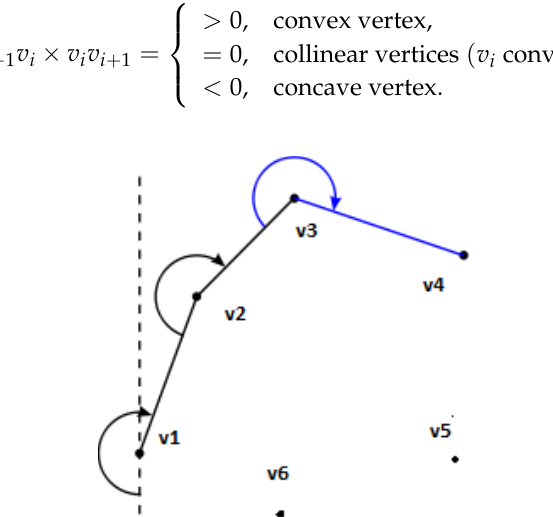
Figure 15. The gift wrap algorithm successively assessing each vertex around a polygon for